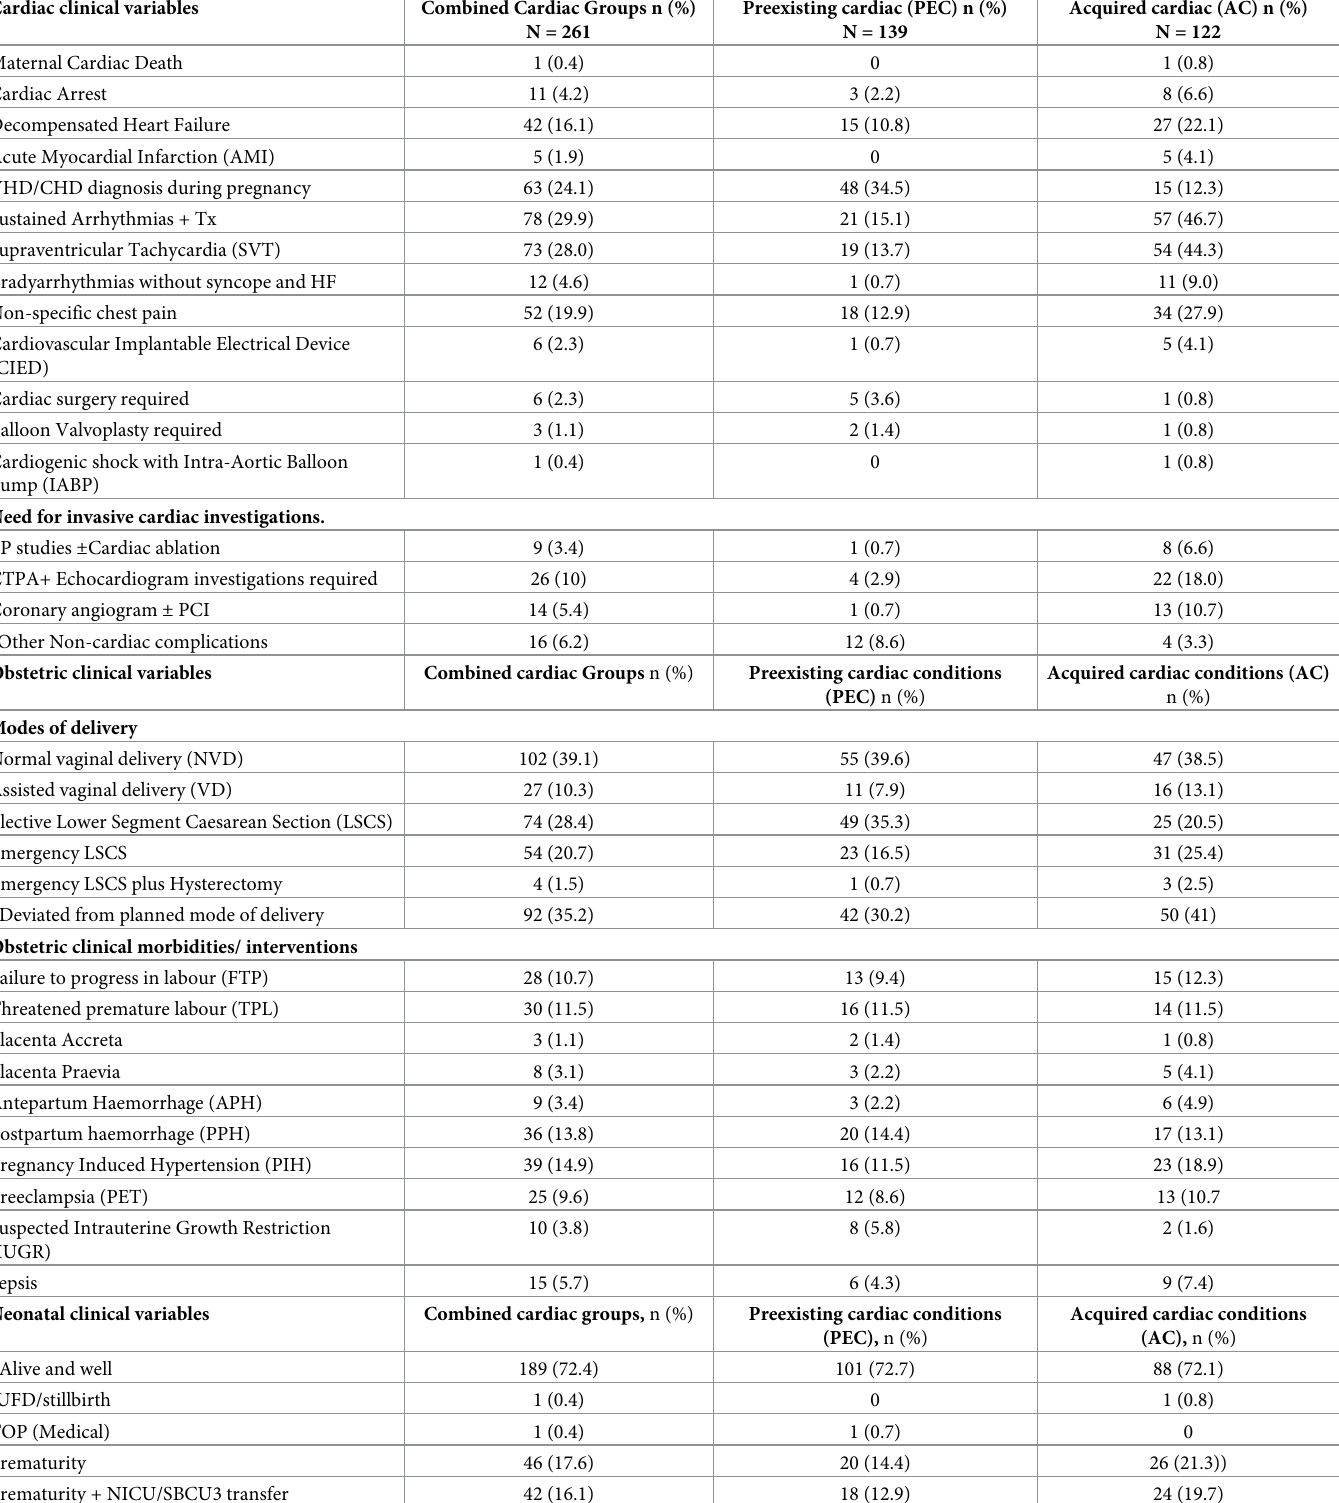
Table 1. The descriptive statistics for clinical variables in the preexistent and acquired cardiac groups of women in South Australia during 2003 and